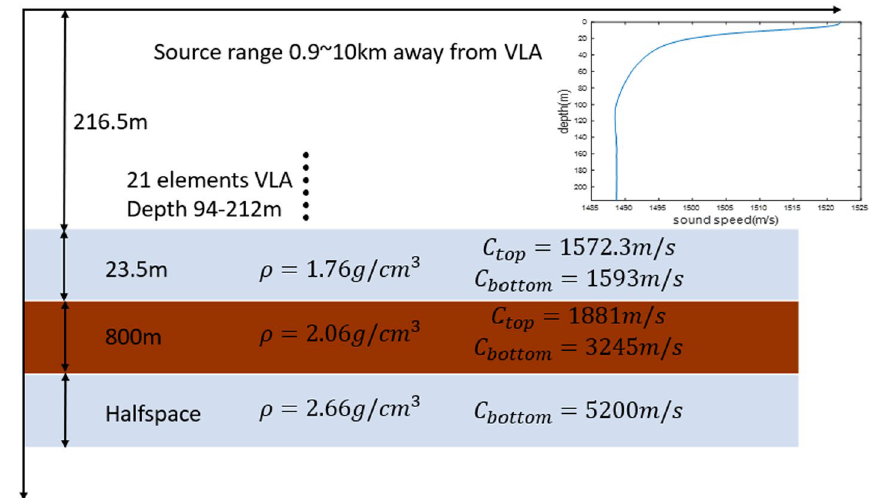
Fig. 4 SWellEX-96 experimental environment parameters